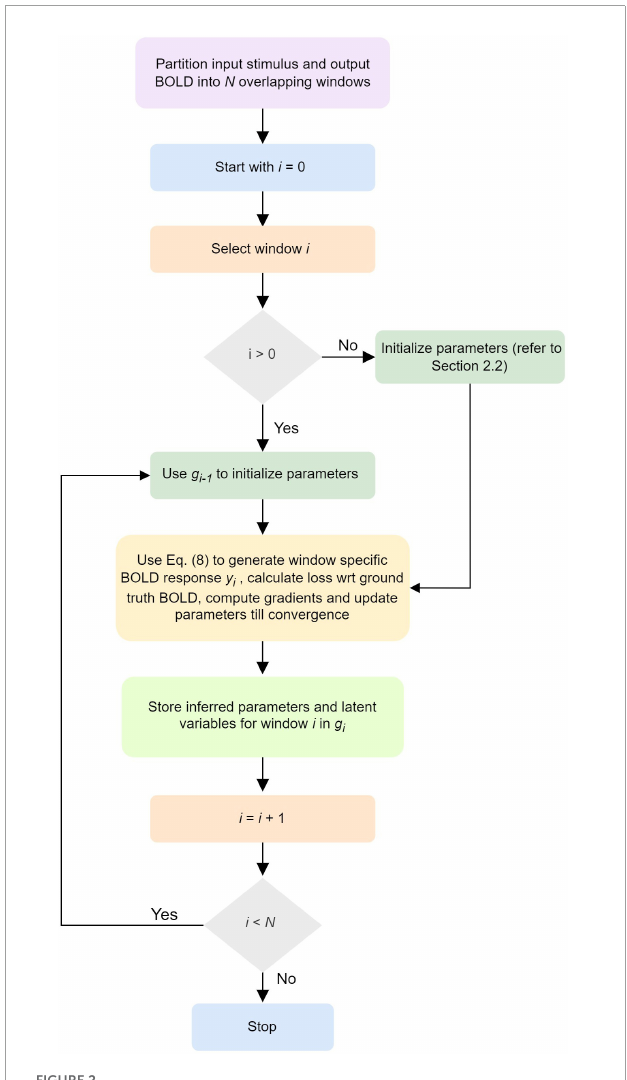
FIGURE2 Workflow of discretized Physiologically informed Dynamic Causal Model ( d P-DCM)-recurrent unit